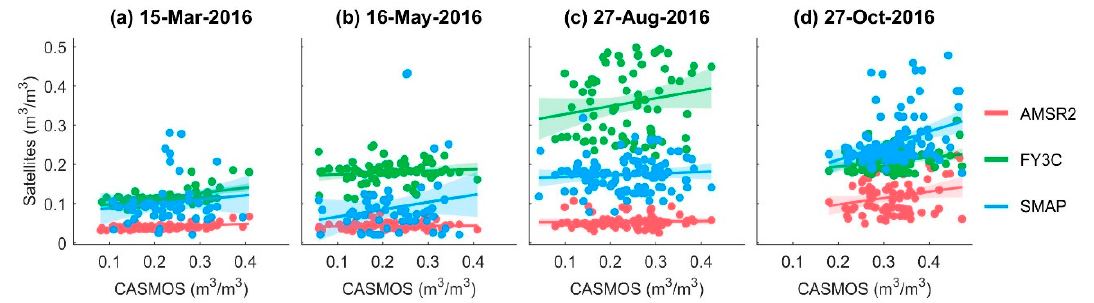
Figure 8. The soil moisture retrievals of the FY-3C, AMSR2, and SMAP products versus in situ SM measurements (CASMOS) on four different dates in 2016. The lines indicate the varying trend of the points.